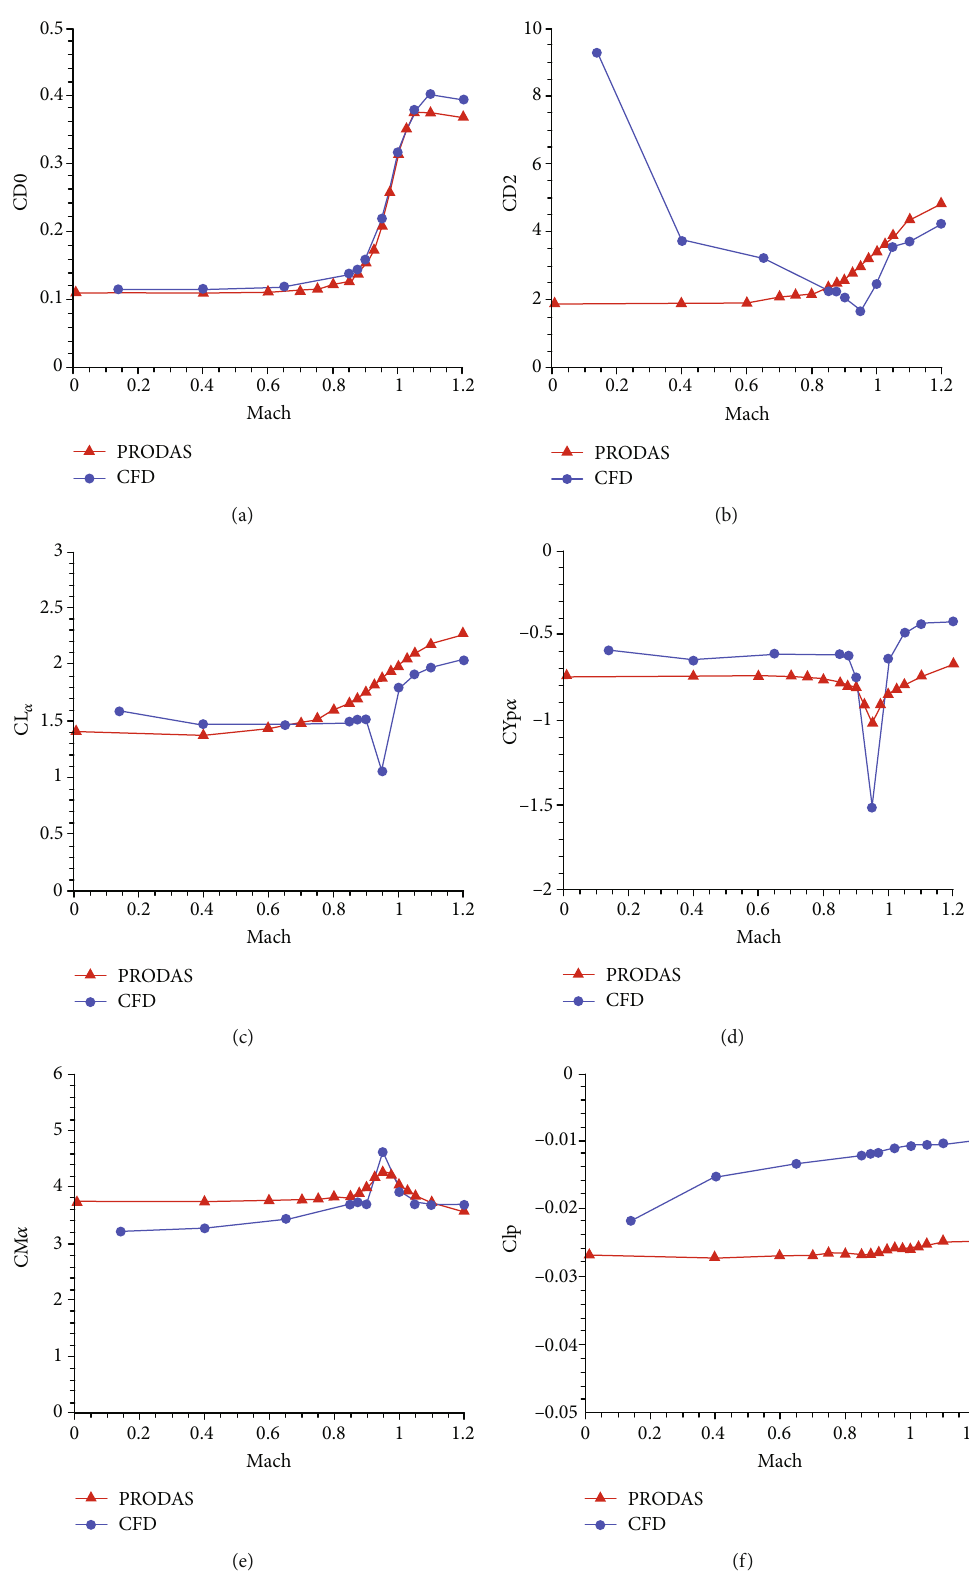
Figure 6: Comparison of aerodynamic coe ffi cients, coe ffi cient of (a) zero yaw drag, (b) quadratic yaw drag, (c) normal force derivative, (d) Magnus force, (e) pitching moment derivative, (f) rolling damping